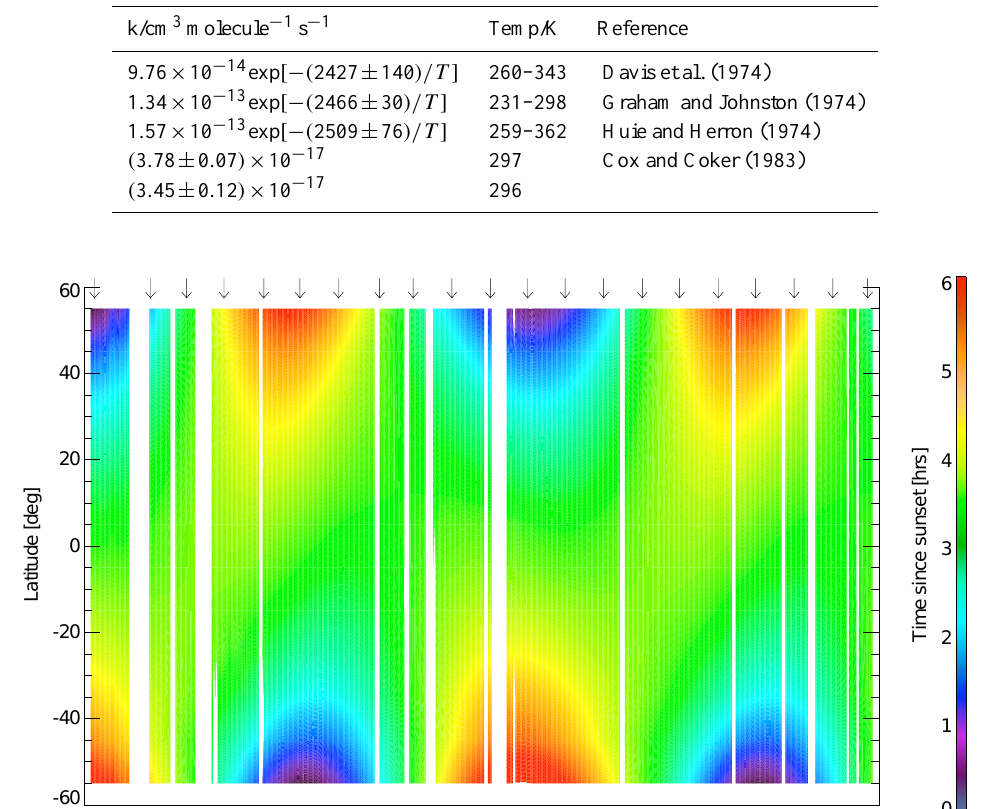
k −→ NO 3 +O 2 adapted from Atkinson et al.